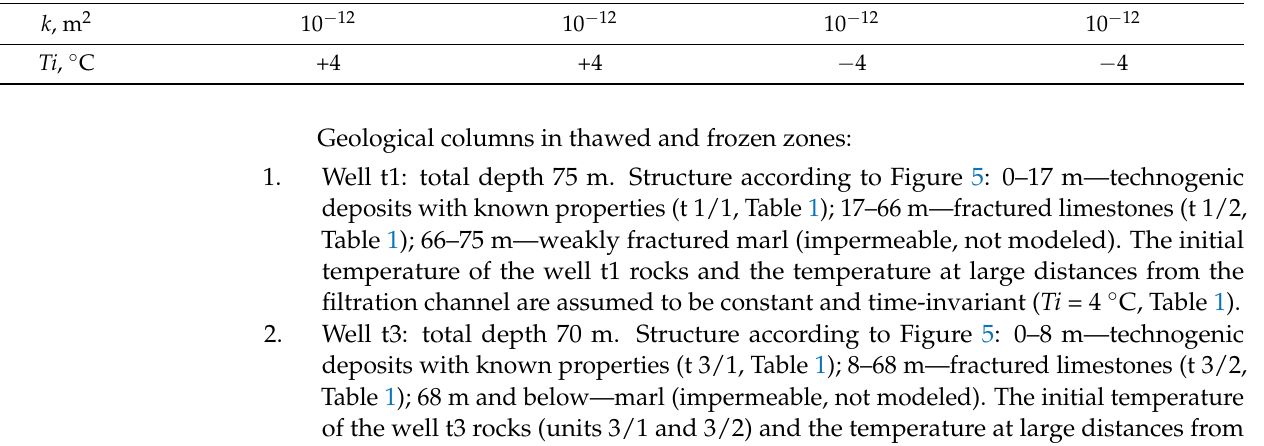
the filtration channel are assumed to be constant ( Ti = -4 °C, Table 1).